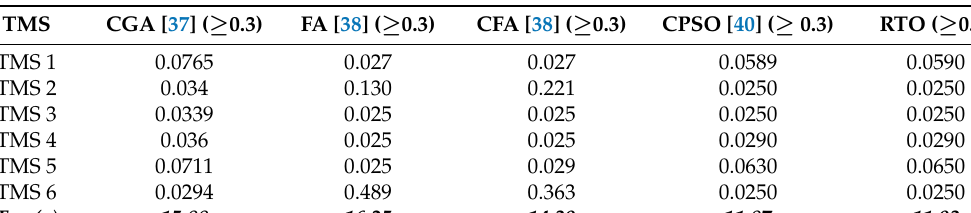
Table 8. Optimal TMS for Case 2.